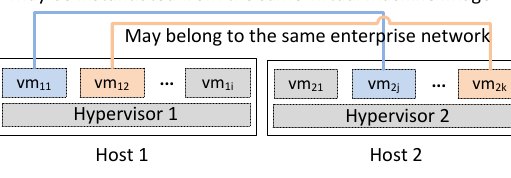
Figure 4. An Example Cloud-level Attack Graph